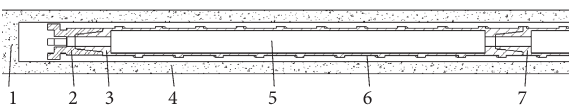
Figure 2: Sketch of slag discharge channel of rib drill pipe. Table 1: Structural parameters of rib drill pipe. Structure